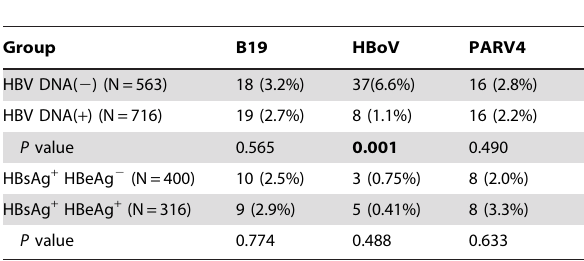
Table 4. Prevalences of B19, HBoV and PARV4 among healthy and chronic HBV patients (HBsAg + HBeAg +